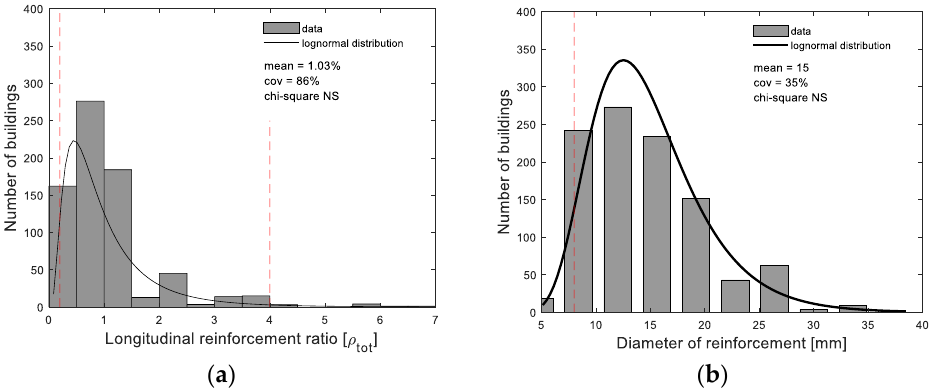
Figure 16. Distribution fitting of buildings regarding columns′ ( a ) longitudinal reinforcement ratio (%) and ( b ) diameter value of longitudinal reinforcement for all RC buildings.